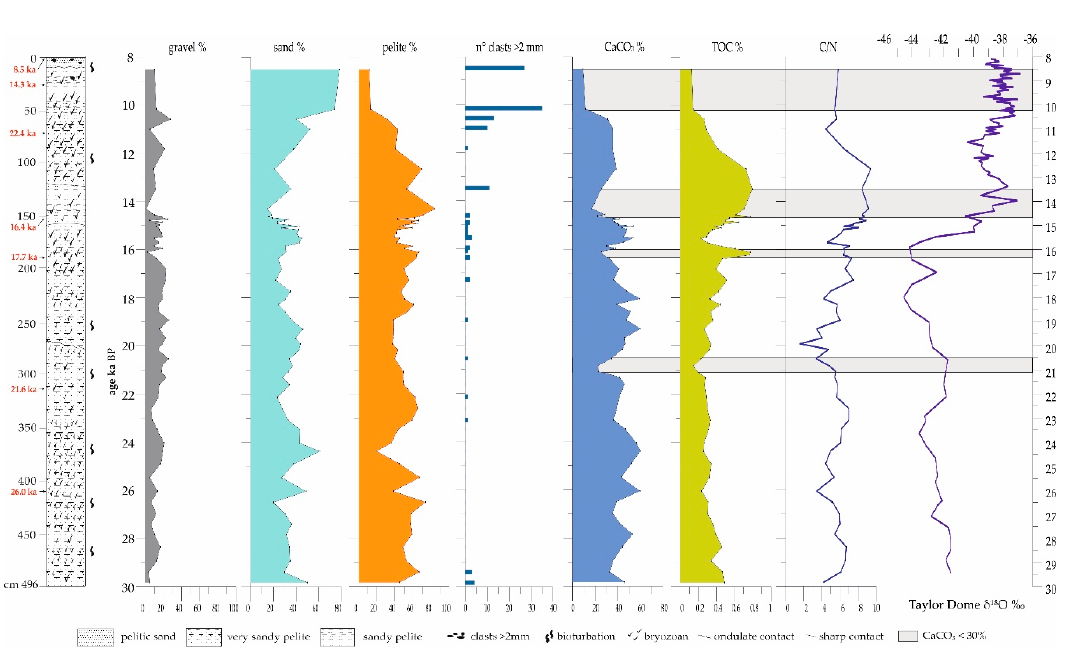
Figure 3. Texture and sediment geochemistry of the studied core. From left to right: down-core distribution of gravel (%), sand (%), pelite (%), number of clasts > 2 mm in size, CaCO 3 (%), organic C (%), C org / N tot contents and δ 18 O in the Taylor Dome ice core, from [55], modified. The time scale (st9507) was used for δ 18 O data. There are a few textural data from [8], modified (see Methods). Authors elaboration Calibrated ages (ka BP) dated by AMS 14 C are reported in red (see Table 1 for details). The top level of this core dates to 8.5 ka BP. Gray areas crossing CaCO 3 and TOC%, C/N and δ 18 O curves represent sediments with CaCO 3 content < 30%.